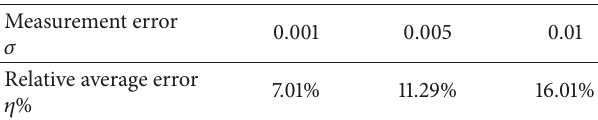
Table 1: Relative average errors of inversion result under different measurement errors given 𝐿 = 0.1𝑚 and 𝑅 = 5 .